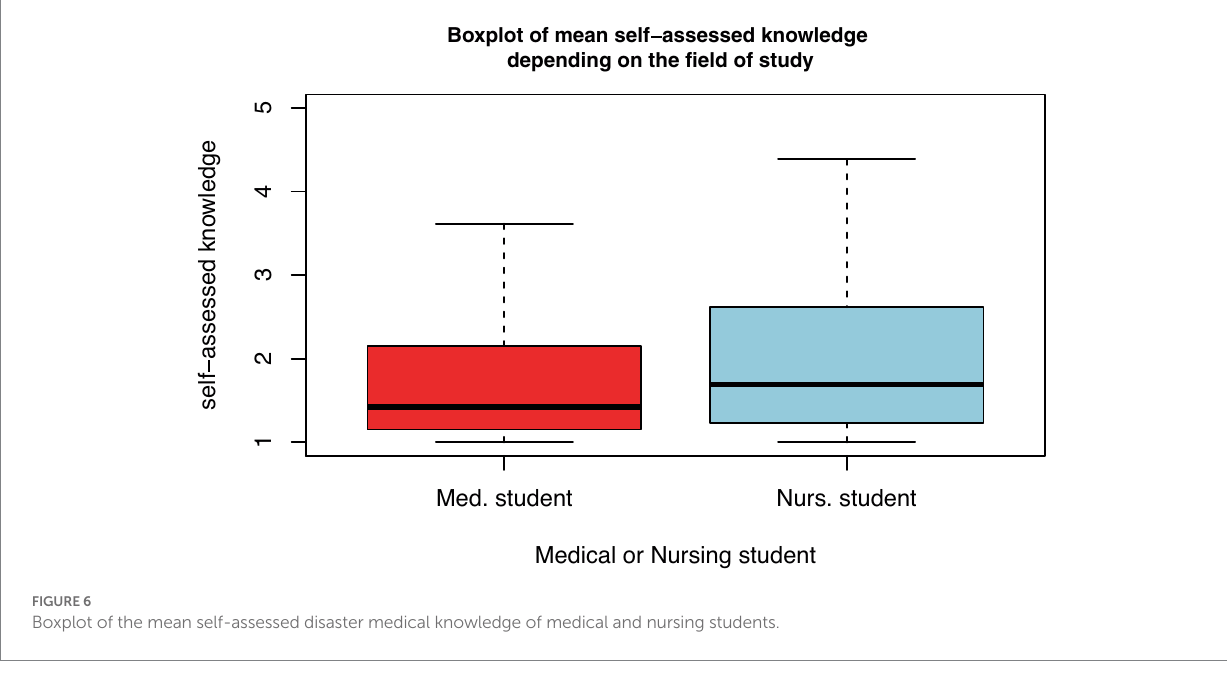
FIGURE 6 Boxplot of the mean self-assessed disaster medical knowledge of medical and nursing students.